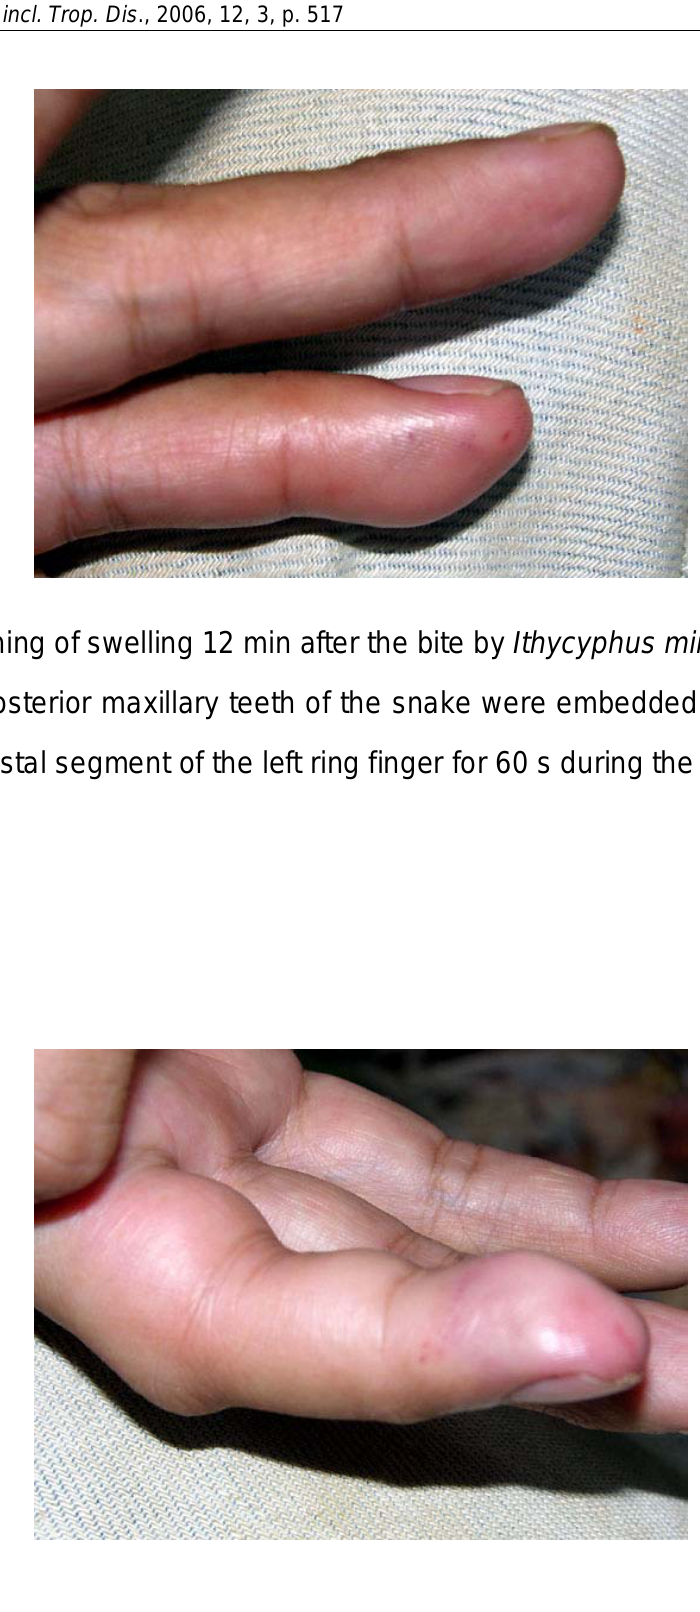
Figure 2: Swelled left ring finger photographed 45 min after the bite (Case